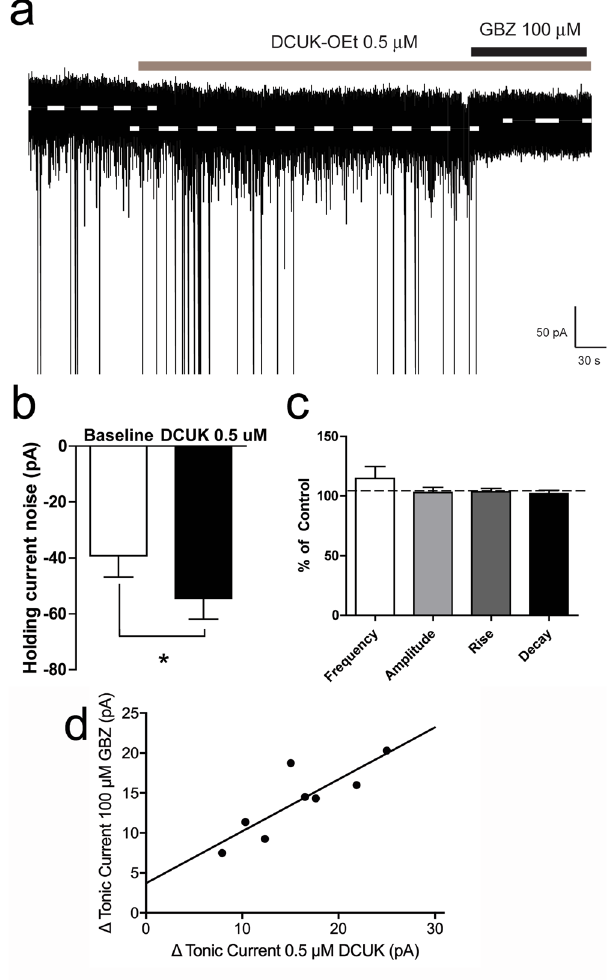
Figure 4. DCUK-OEt potentiates tonic currents in medial CeA neurons. ( a and b ) Focal application of DCUK- OEt (0.5 µ M) significantly increased the holding current in medial CeA neurons ( * p < 0.05, paired t-test). ( c ) No change was evident in frequency, amplitude, rise and decay of mIPSPs with focal application of DCUK-OEt. ( d ) Correlation of magnitude of increase in tonic current produced by 0.5 μ M DCUK-OEt with reduction of current by subsequent application of 100 μ M gabazine. To demonstrate that changes in holding current were due to increases in tonic signaling, the GABA A receptor antagonist gabazine (GBZ) (100 μ M) was focally applied following DCUK-OEt application. For all graphs, n = 11